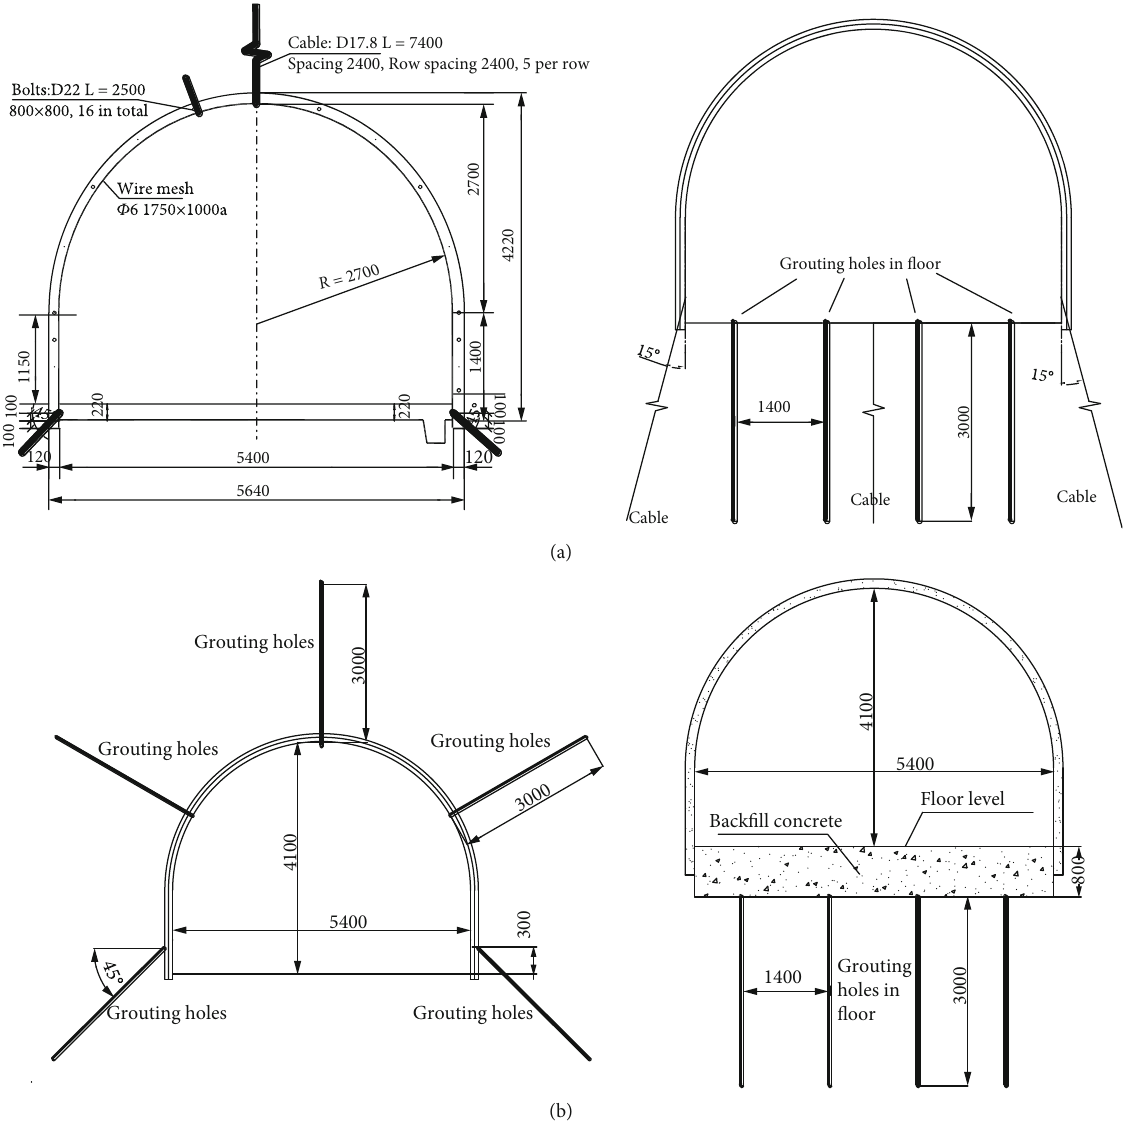
Figure 13: Cross-section of